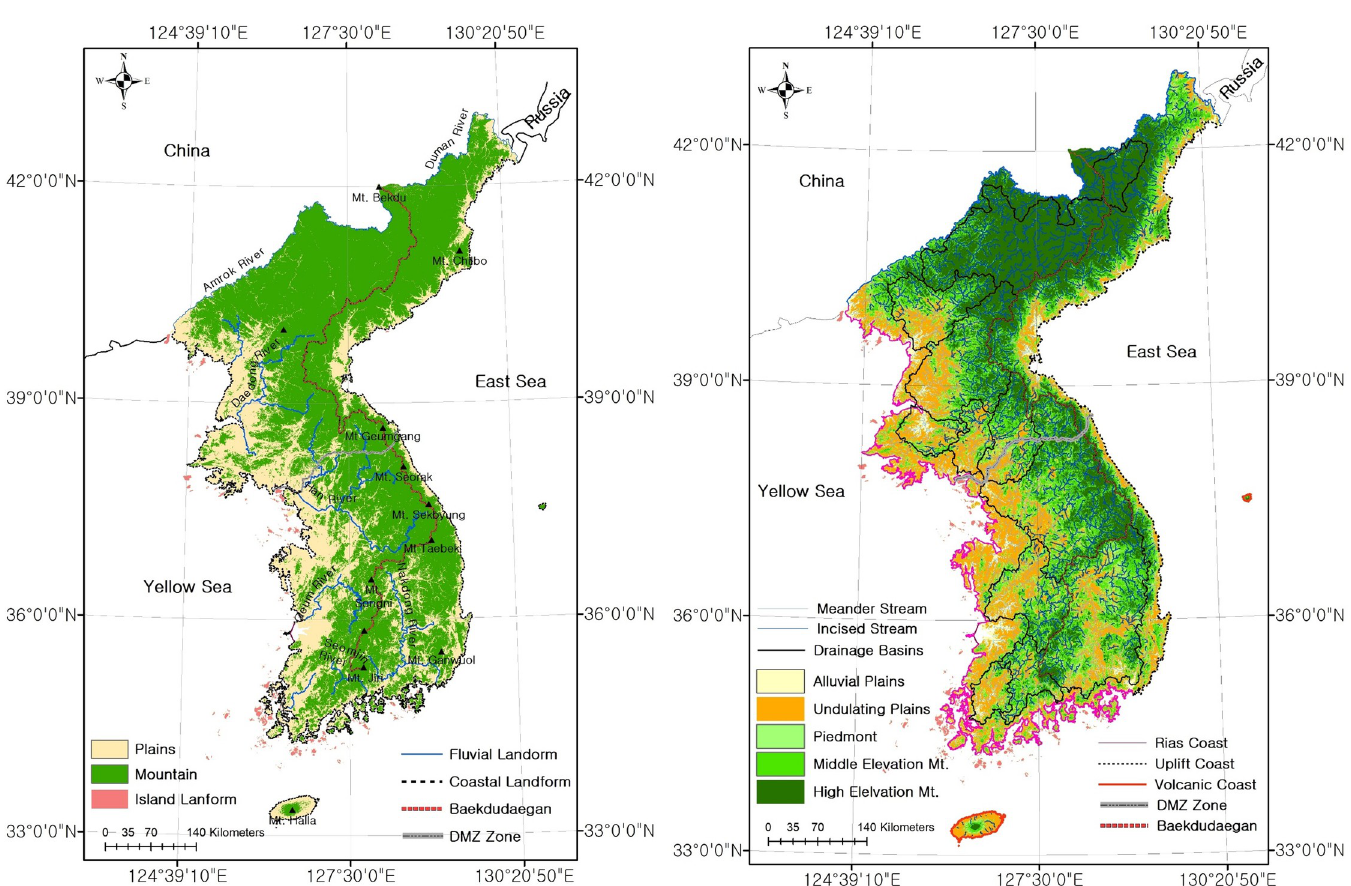
Fig 3. Result of habitat categorization by classification scale (left: Category 1, right: Category 2; base map data source: Https://gadm.org/).